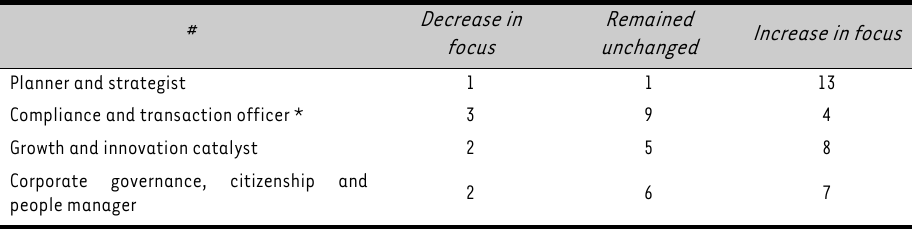
TABLE 7: Effects of the global financial crisis on the four roles of a CFO Decrease in Remained # Increase in focus focus unchanged Planner and strategist 1 1 13 Compliance and transaction officer * 3 9 4 Growth and innovation catalyst 2 Corporate governance, citizenship and people